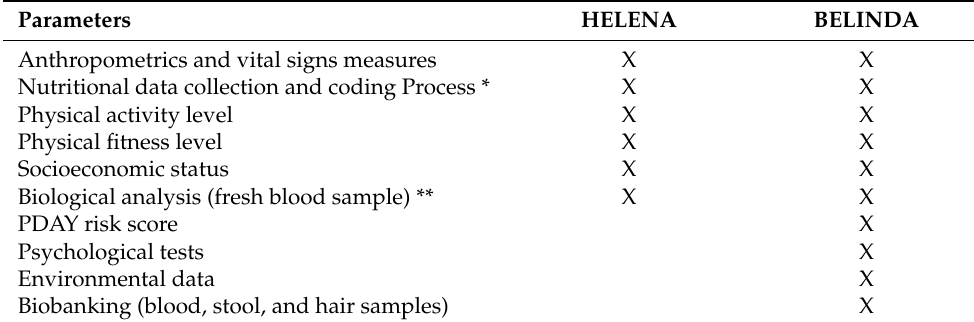
Table 1. Data set, tools, and process shared by HELENA and BELINDA studies. Parameters HELENA BELINDA